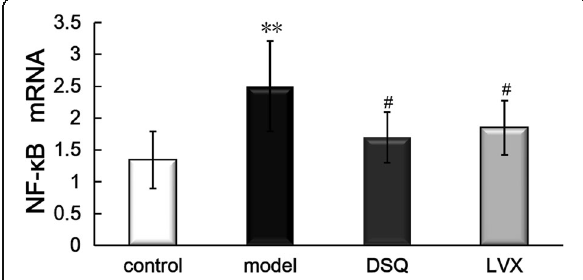
Fig. 3 Expressions of NF- κ B mRNA in the lungs in control,